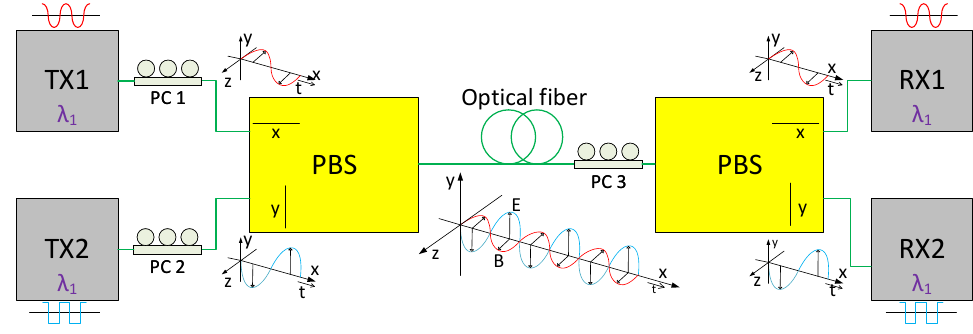
Figure 1. Principle of the polarization multiplex. Multiplexed signals contain two differently modulated optical signals, which may have the same wavelength. These signals pass through an optical distribution network, at the end of which another polarization controller is used for rotation of the polarization process—each signal must be parallel to the polarization planes of the second polarization beam splitter, which is used for polarization demultiplexing. This ensures that the desired output signal is included in each polarization output